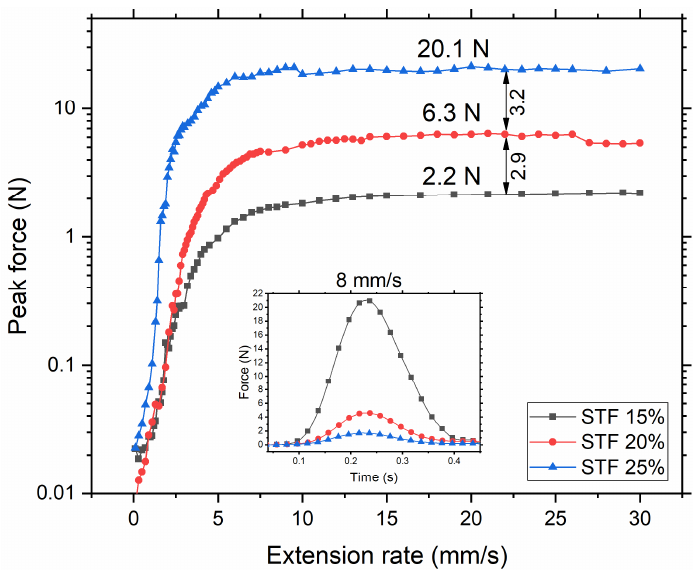
Figure 4. Extensional “pull-up” test. Peak forces at each individual extensional rate test are plotted against the rate, and peak forces are plotted in a log scale. Normal force profile at 8 mm/s is shown in the middle of the figure; at this rate, peak force values reach the plateau. All curves reach a plateau around 8 mm/s. This value of peak force represents the maximum DST/SJ exhibited by the STF sample during the extensional tests. Comparing the peak force at 8 mm/s, the STF 25% sample shows an 11.7 times higher peak force than that of the 15 % sample. In James et al.’s experiment [20], the presence of shear jamming is determined by a significant increase in normal force recorded at 8 mm/s. The peak force value of 12.0 N in PMMA/ITA suspension was shown to originate from SJ rather than just from shear thickening, whereas a non-SJ glass beads suspension demonstrated only 1 N of normal peak force at the same extension rate. Drawing parallels with our results (20.1 N for STF 25% at 8 mm/s), it can be concluded that the high normal force in STF 25% is attributed to the presence of shear jamming. It is also worth noting that a pulling force of 20.1 N for 25 wt% STF corresponds to stress exceeding 65 kPa, which is noticeably larger than that achieved during flow tests. This stress far exceeds stresses from the lubrication model or stresses that can be achieved with capillary forces [1,27,41]. Therefore, such high stresses originate from the frictional interaction between the particles. Sterically dispersed particles need to overcome repulsive forces to come into contact with each other, which causes a drastic increase in peak force. 3.2. Low-Velocity Impact Behavior of STF Drop weight impact test was used to analyze the impact response of STF in the low velocities range. The 13 mm thick layer of STF was subjected to six different impact ener- gies based on the height of a 5 kg hemispherical impactor. The peak forces of three STF with different fumed silica concentrations are present in Figure 5a. The peak forces were plotted on a logarithmic scale to correlate with rheological data. At 5 J, all STFs demon- strated sufficiently low and close values of peak forces, suggesting that the impact was within their capacity. After 5 J, the curves start to move away from each other. The peak force of STF 15% increased over three times at 10 J with a relatively consistent growth after. The shape of the curve, however, suggests that there is a plateau to which this curve tends. STF 20% demonstrated an almost linear growth until 20 J with the same trend as for STF 15%, where peaks forces increase less and may eventually reach the plateau. This suggests that, after 20 J, STF reaches the maximum capacity to bear the impact with the